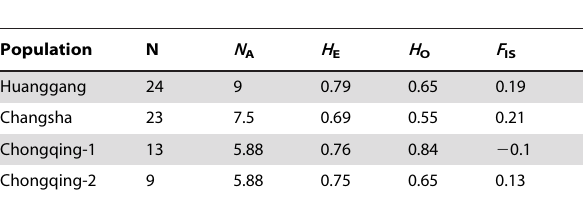
Table 1. Summary statistics for the four genetically differentiated populations.